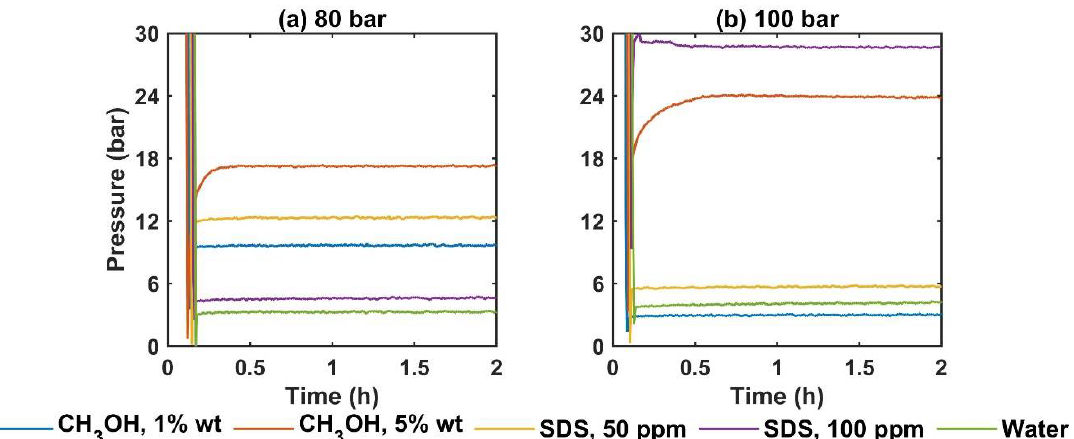
Figure 8. Pressure behavior of CH 4 hydrate at T = −2 °C and T = −4 °C after the system of hydrate and ice is rapidly expanded to atmospheric pressure. Self-preservation is studied at T = −2 °C and T = −4 °C. ( a ) Pressure response curve for Pi = 80 bar, T = −2 °C ( b ) Pressure response curve for Pi = 100 bar, T = −4 °C.